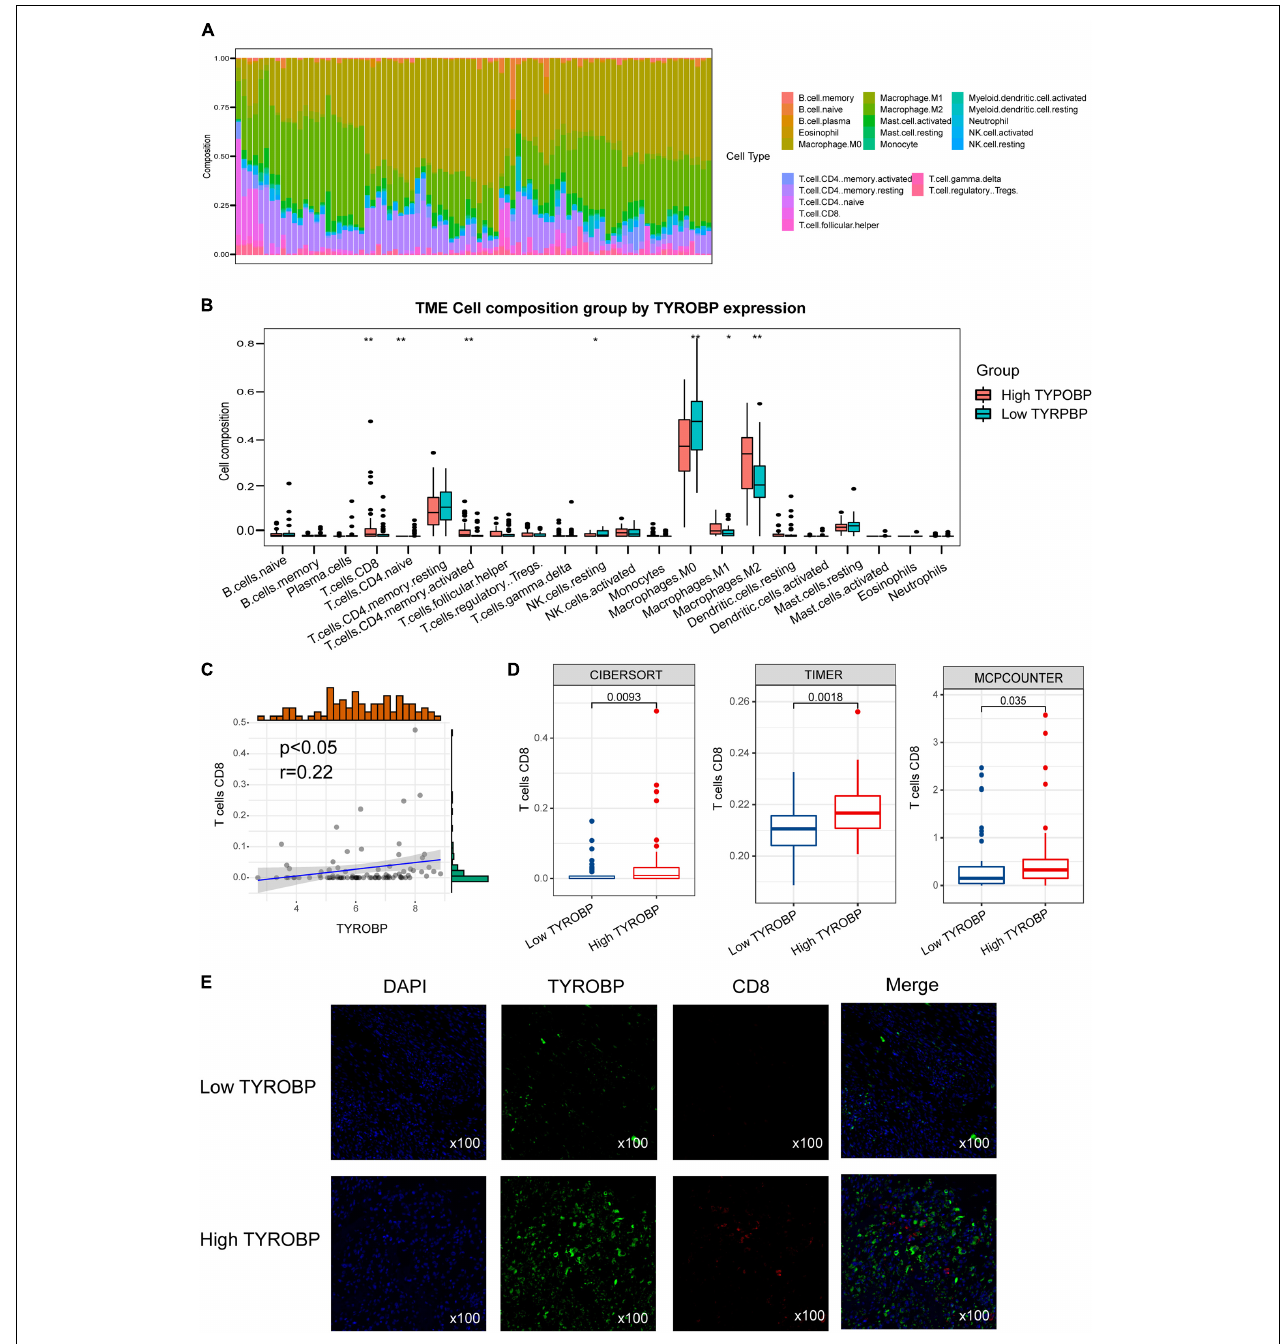
FIGURE 5 | (A) Relative proportion of immune infiltration in Immune_H and Immune_L groups; (B) box plots visualizing significantly different immune cells between Immune_H and Immune_L groups; (C) correlation of TYROBP and CD8 + T cell infiltration; (D) box plot showed CD8 + T cell infiltration level in TYROBP high and low groups; (E) multiplex immunohistochemistry validated differentially infiltrated CD8 + T cell in TYROBP high and low groups. ** p < 0.01, *** p < 0.001, and **** p < 0.0001.